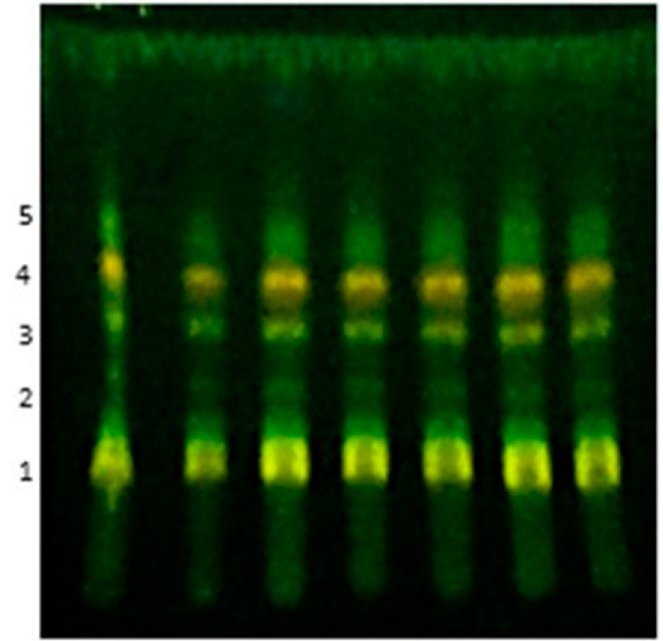
Figure 1. Thin-layer Chromatography from seven batches of aqueous extract of M. chamissois Naudin (AEMC). Each column represents one extraction batch. The leaves were collected in May 2017. The stationary phase was silica gel, and the mobile phase was a mixture of ethyl acetate, formic acid, acetic acid, and deionized water (100:11:11:26). Chromatographic spots were visualized using an ultraviolet lamp at 254 nm and the NP/PEG reagent. 1: R f 0.17, 2: R f 0.33, 3: R f 0.43, 4: R f 0.54 and 5: R f 0.61. The polyphenol and flavonoid analysis results are expressed as the average of the seven batches. The TP content found in AEMC was 19.65 ± 0.43 µ g QE/mg (RSD = 2.19%) and the TF content was 2.49 % ± 0.15 (RSD = 5.55%). Pearson (r) linear correlation was performed to assess the correlation between total polyphenol content and extractable solids content. A weak negative correlation (r = − 0.20; p = 0.37) was not significant between the evaluated parameters. In general, the